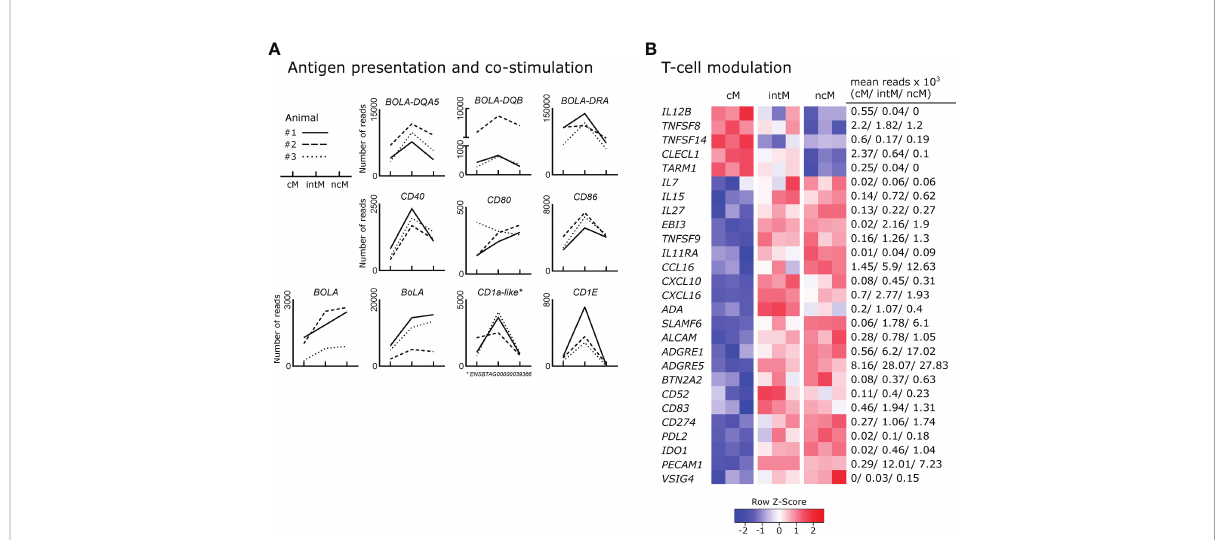
FIGURE 5 Expression of genes involved in the shaping of T-cell responses. Illumina sequencing was performed on RNA isolated from sorted monocyte subsets (cM, intM, ncM) of three animals (#1-3). (A) Gene expression promoting antigen presentation and co-stimulation. Graphs show the number of reads across monocyte subsets for selected genes with individual animals indicated by solid (#1), dashed (#2) and dotted (#3) lines. (B) Gene expression involved in T-cell modulation. Heatmap shows row z-scores calculated from log2-transformed normalized counts of selected genes. Mean kilo reads for each subset and gene are given to the right of the heatmap. Genes were selected based on pairwise comparisons with DESeq2 (adjusted p-value < 0.05) and literature